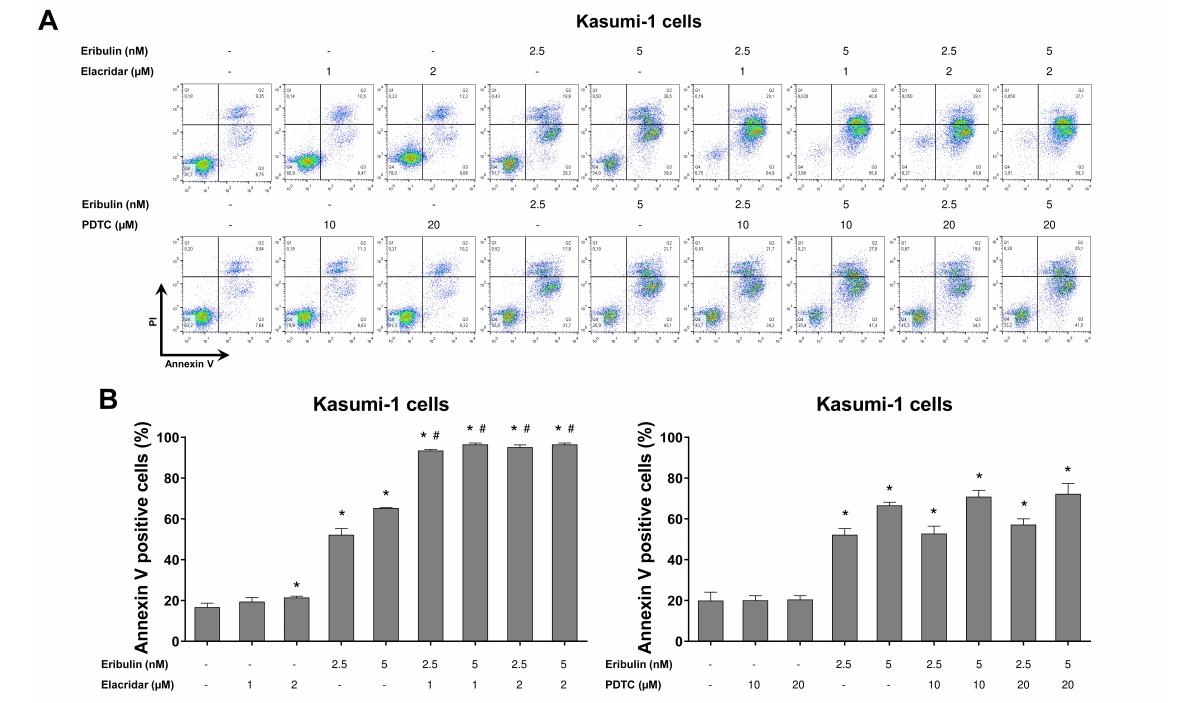
Figure 8. Elacridar, a P-glycoprotein inhibitor, potentiates eribulin-induced apoptosis in Kasumi-1 cells. ( A ) Apoptosis was detected by flow cytometry using APC-annexin V and propidium iodide staining. Representative dot plots are counters for each condition; the upper and lower right quad- rants cumulatively the apoptotic population (annexin V + cells). ( B ) Bar graphs represent the mean ± SD of at least three independent experiments quantifying apoptotic cell death in Kasumi-1 cells after exposure to the vehicle, eribulin (2.5 and 5 nM) and/or elacridar (1 and 2 µ M) and/or PDTC (10 and 20 µ M) for 72 h. The p values are indicated in the graphs; * p < 0.05 for eribulin-, elacridar-, and/or PDTC-treated cells vs. vehicle-treated cells, # p < 0.05 for eribulin-, elacridar-, or PDTC-treated cells versus combination treatment at the corresponding doses; ANOVA and Bonferroni